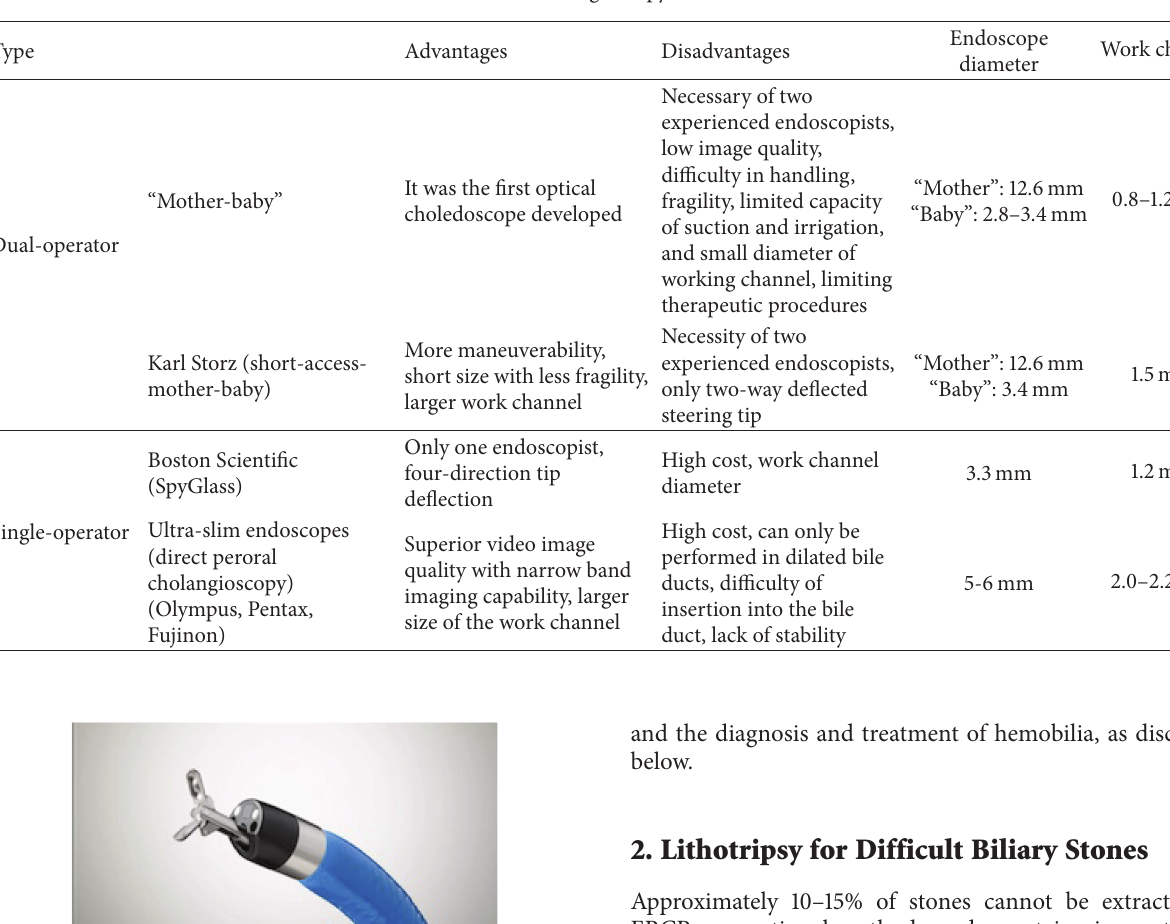
Table 1: Cholangioscopy modalities.